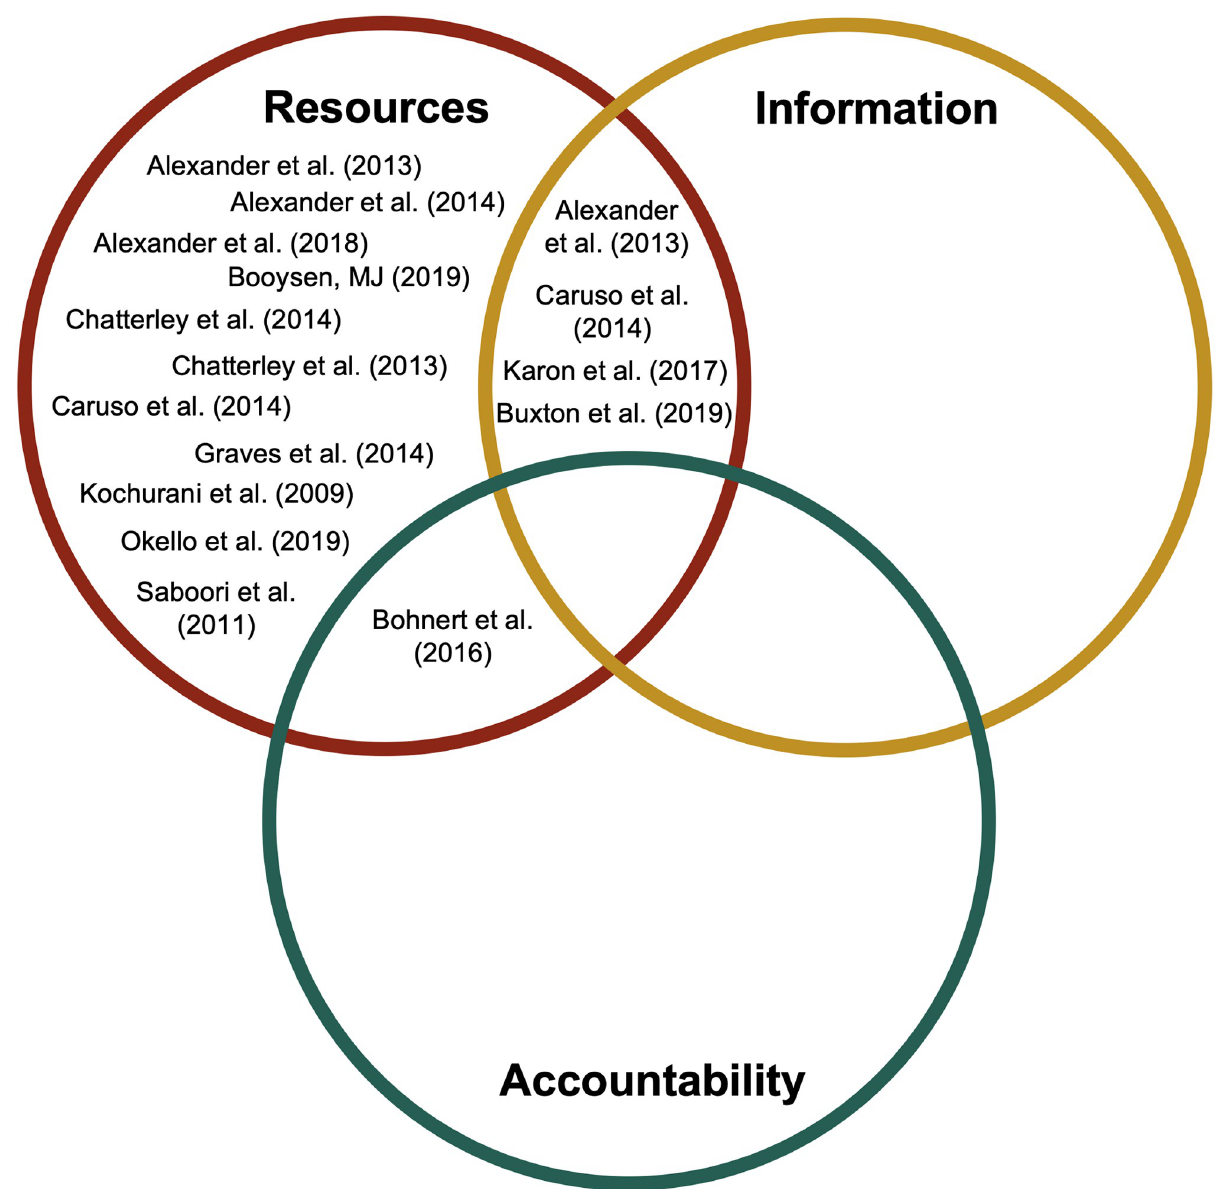
Fig 4. Classification of experimental, quasi-experimental, and observational studies based on components of implemented interventions. Studies may appear more than once if they featured multiple intervention arms. Saboori et al. (2013) and Snyder et al. (2020) are not included because the same interventions are already represented by Caruso et al. (2014) and Bohnert et al. (2016),